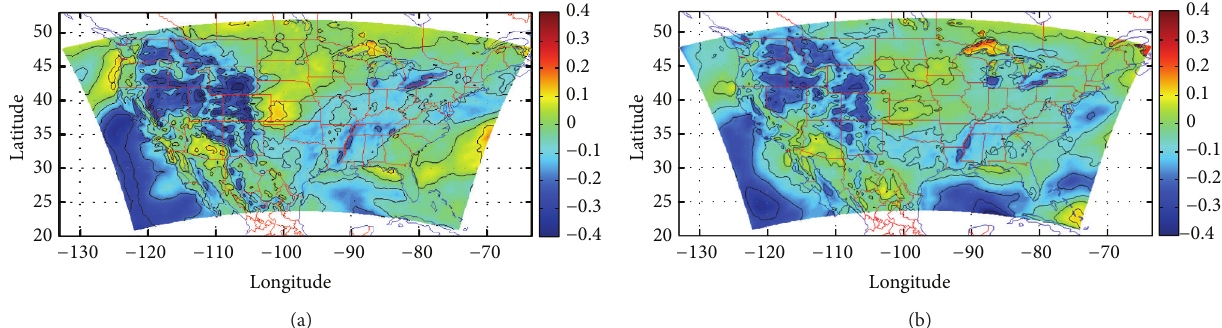
Figure 8: (a) Difference of average annual mean wind speed (ms −1 ) between 2040s and 1990s (current climate) and (b) difference of average annual mean wind speed (ms −1 ) between 2090s and 1990s (current